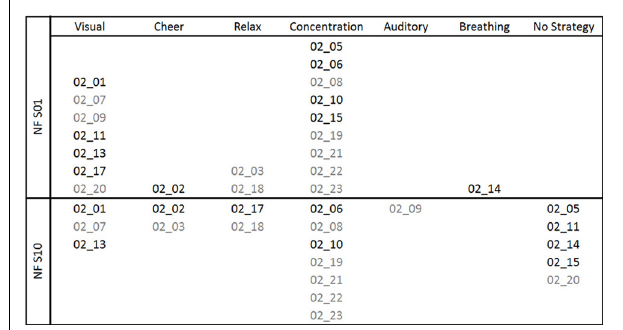
FIGURE 1 | Mental strategies used during the first (NF S01) and the last (NF S10) NF training session, presented separately for each participant of the SMR (subject code in black font color) and Gamma group (subject code in gray font